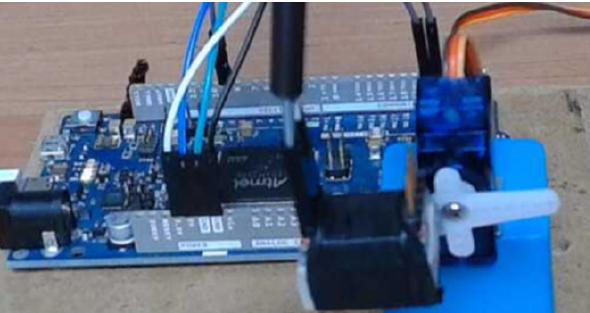
Figure 11. The real view of experimental setup with Arduino Due development board and MPU9252 IMU mounted on a shaft of servo motor in lock